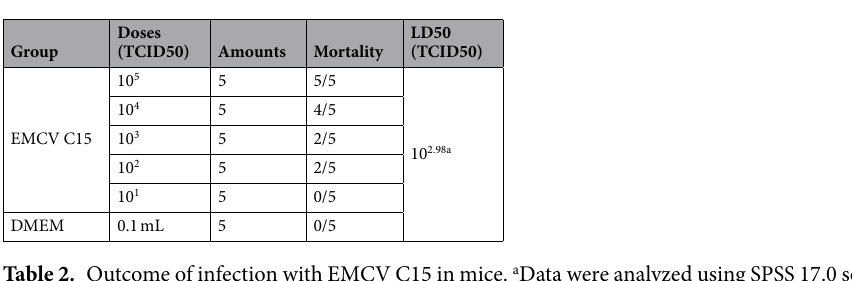
Table 2. Outcome of infection with EMCV C15 in mice. a Data were analyzed using SPSS 17.0 software. One- way ANOVA followed by Duncan’s multiple range test was used to compare the parameters among the different groups.